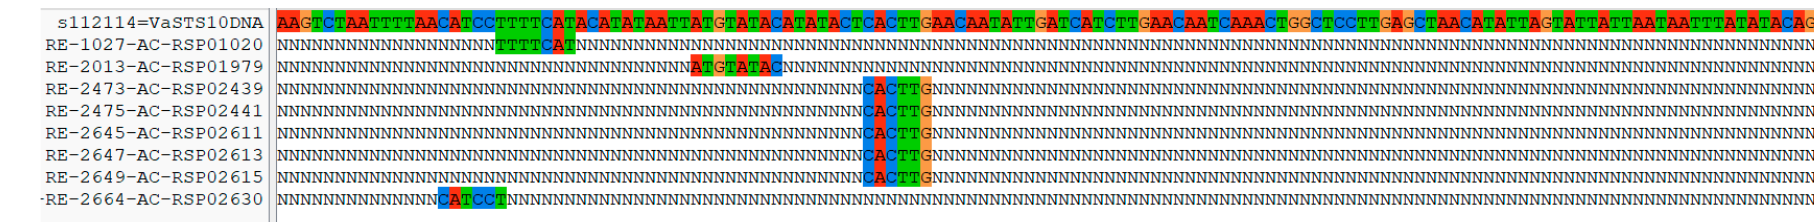
Figure 4. Regulatory elements found in the single 135 bp intron of the VaSTS11gene using NSITE-PL database [7].